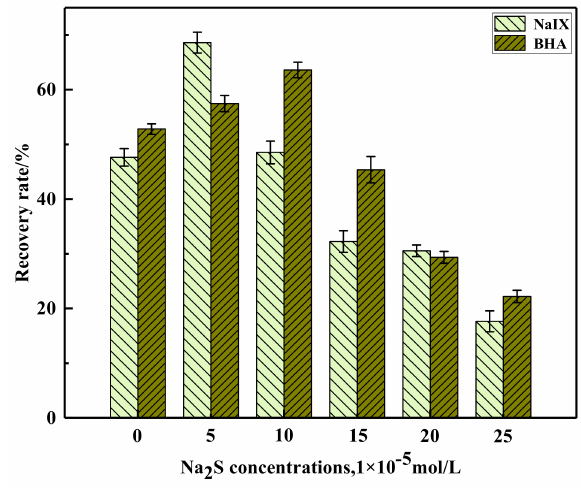
Figure 4. Effect of Na 2 S dosage on azurite floatability.